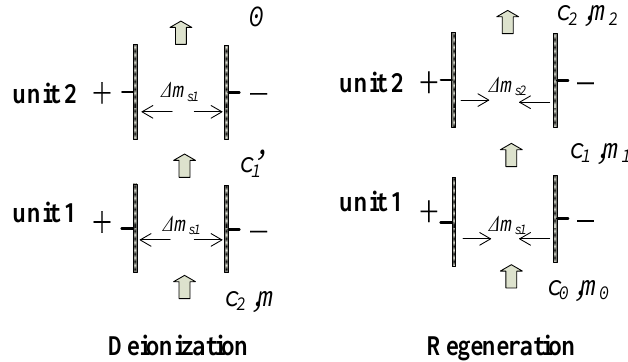
Water Storage pool Figure 3. Flow chart of the double-stage CDI absorption air-conditioning system.